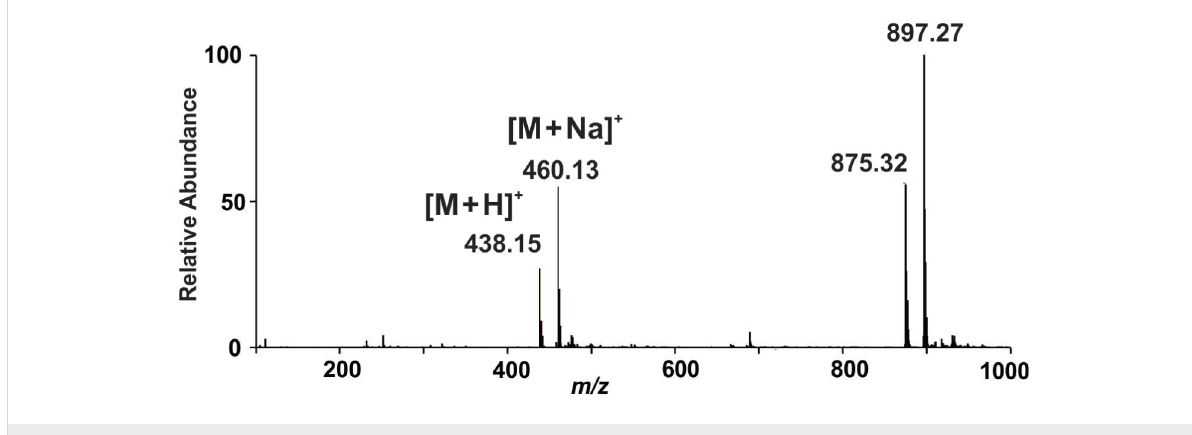
Figure 2: ESI mass spectrum of 2 (positive ion mode).